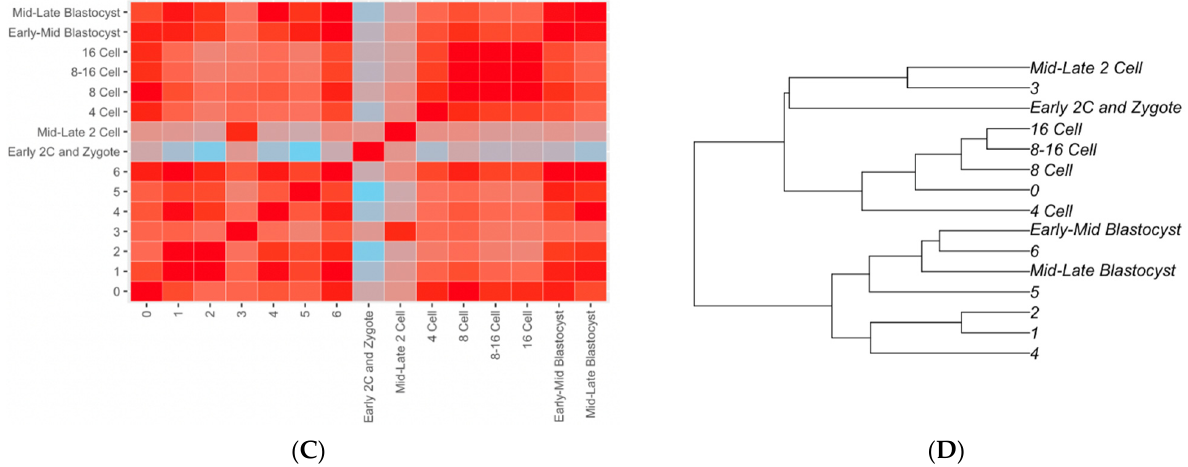
Figure 8. Transcriptomic analyses of TBLCs cluster 3 compared to other TBLCs clusters and in vivo mouse early develop- mental stages. ( A ) A heatmap showing average differential upregulated gene expression of TBLCs clusters, zygote-early 2-cells, and mid-late 2-cells. Scale bar represents z-scored gene expression value. ( B ) A heatmap showing average gene expression of TBLCs cluster 3 downregulated genes compared with other TBLCs clusters and 2-cell stage cells. Scale bar represents z-scored gene expression value. ( C ) A correlation matrix of TBLCs clusters and early mouse embryonic developmental stages based on first 20 PCs using Pearson’s correlation coefficient method. Scale bar indicates correlation coefficient. ( D ) A hierarchical clustering tree of TBLCs clusters and early mouse embryonic developmental stages based on first 20 PCs.